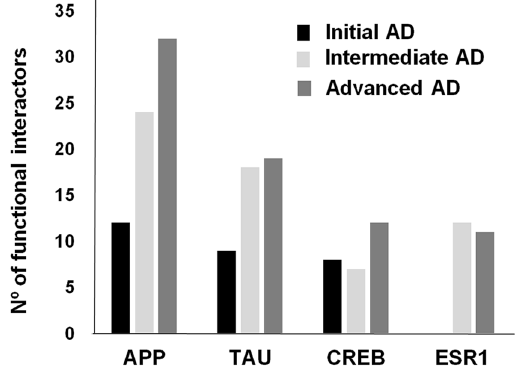
Figure 5. Functional interactome distribution across AD stages. The number of predicted functional interactors for hub proteins with impact in neurobiology is